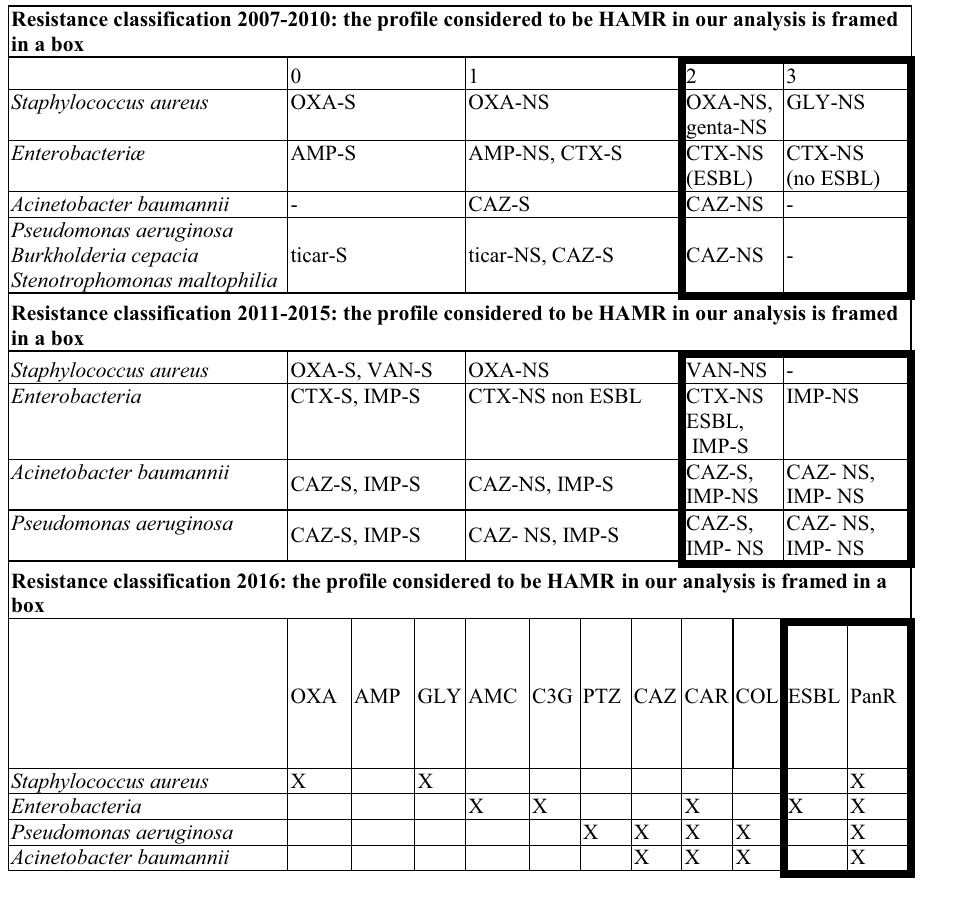
Table 1. Evolution of the classification of the antimicrobial resistance by year and by micro-organisms in the REA-RAISIN database. NS = Non-susceptible S = susceptible OXA: oxacillin (or methicillin), AMP: ampicillin (or amoxicillin), GLY: glycopeptide (vancomycin or teicoplanin), AMC: amoxicillin-clavulanic acid, ticar: ticarcillin, C3G: 3rd generation cephalosporins = cefotaxime (or ceftriaxone) PTZ: piperacillin-tazobactam, CAZ: ceftazidime, CAR: carbapenem = imipenem or doripenem or meropenem, IMP: imipenem, VAN: vancomycin, COL: colistin, ESBL: extended-spectrum beta-lactamase-producing, PANR:non susceptible to all tested agents, HAMR: highly